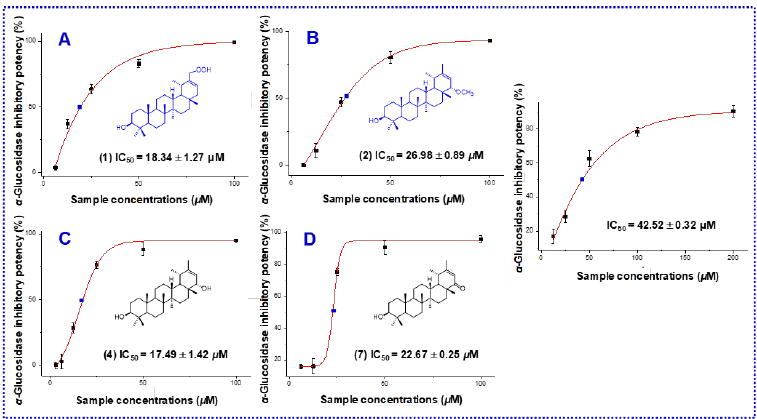
Figure 3. Half-maximal inhibitory concentrations (IC 50 ) of compounds 1 ( A ), 2 ( B ), 4 ( C ), and 7 ( D ), the positive control acarbose on α -glucosidase in vitro.